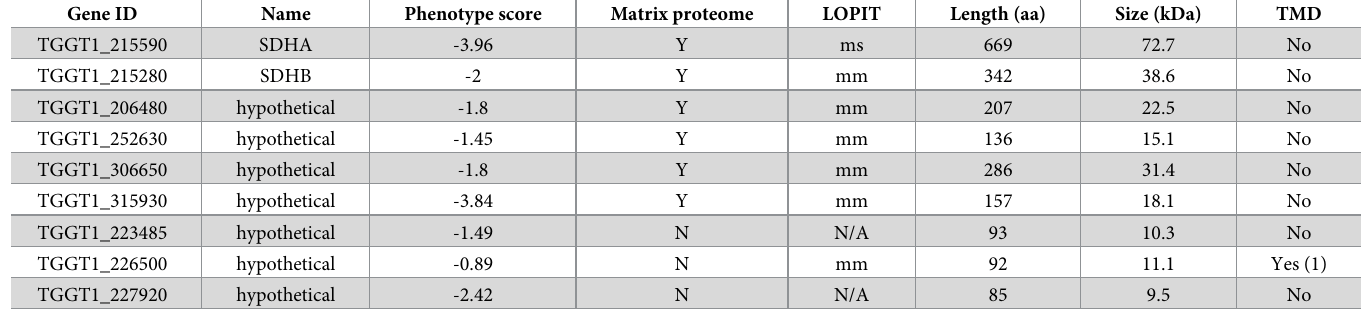
Table 1. Details of putative complex II subunits. Phenotype scores were taken from Sidik et al., 2016 [56]; Matrix proteome from Seidi et al., 2018 [7] (Y–present in proteome, N–absent); LOPIT from Barylyuk et al., 2020 [36] (mm–mitochondrial membrane, ms- mitochondrial soluble N/A–not identified in dataset). TMD: Transmembrane domain, predicted by